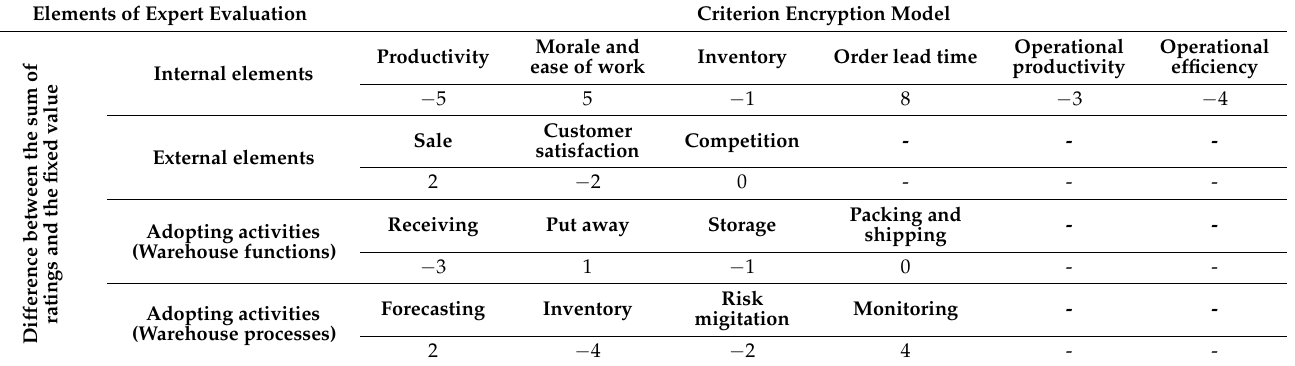
Table 9. The results of the expert evaluation of difference between the sum of ratings and the fixed value.